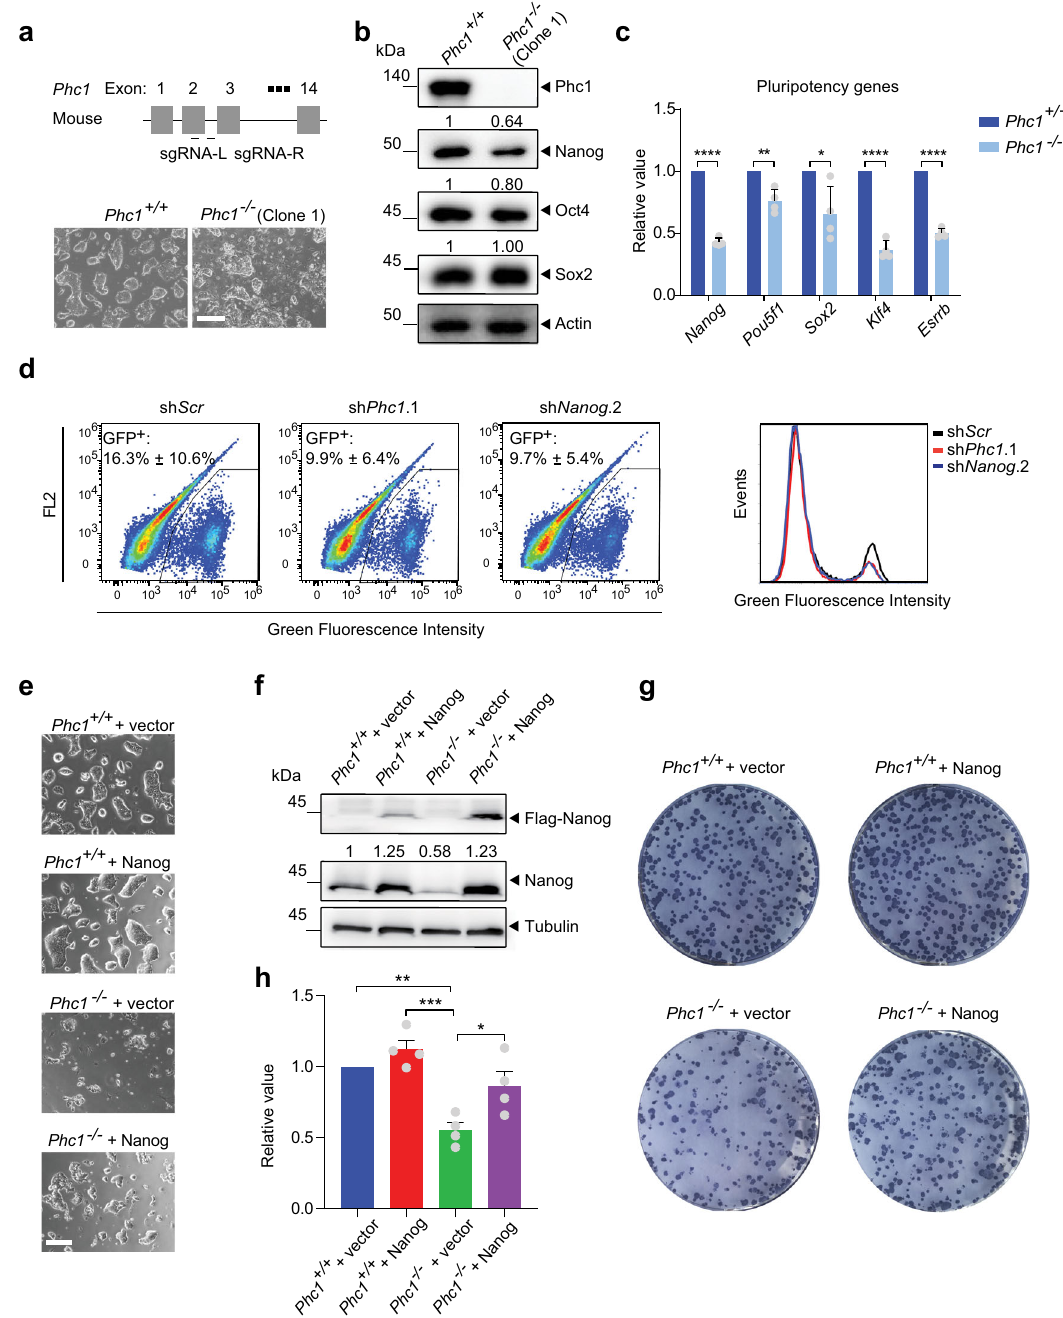
Fig. 3 Phc1 maintains pluripotency of mESCs partly through Nanog. a Designing sgRNAs targeting the 2nd exon and 3rd intron of mouse Phc1 , and the morphology of the Phc1 + / + and Phc1 − / − mESCs. Scale bars, 300 μ m. b WB analysis of Phc1, Nanog, Oct4, Sox2, and Actin protein levels in the Phc1 + / + and Phc1 − / − mESCs. c qPCR analysis of transcript levels of Pou5f1 , Sox2 Nanog , and its known direct target genes including Klf4 and Esrrb . Mean ± s.d. of n = 4 independent experiments. Two-tailed t -tests were used ( p < 0.0001 for Nanog ; p = 0.0023 for Pou5f1 ; p = 0.0216 for Sox2 ; p < 0.0001 for Klf4 ; p < 0.0001 for Esrrb ). d Flow cytometry analysis quantifying GFP signal after Phc1 knockdown in a mESC line carrying the Nanog -GFP reporter. Nanog suppression was used as the positive control. Mean ± s.d. of n = 3 independent experiments. e Morphology of Phc1 + / + and Phc1 − / − mESCs transfected with an empty or Flag-Nanog vector. Scale bars, 600 μ m. f Immunoblotting of Flag, Nanog, and Tubulin in extracts of mESCs in ( e ). g Alkaline phosphatase staining of mESCs in ( e ). h Quanti fi cation of colony-forming ef fi ciencies of mESCs relative to Phc1 + / + + vector as the control in ( e ). Mean ± s.e.m. of n = 4 independ e nt experiments. One-way ANOVA test with Bonferroni ’ s multiple comparison was used ( ** p = 0.0024, *** p = 0.0003, * p = 0.0319). Source data are provided as a Source Data fi